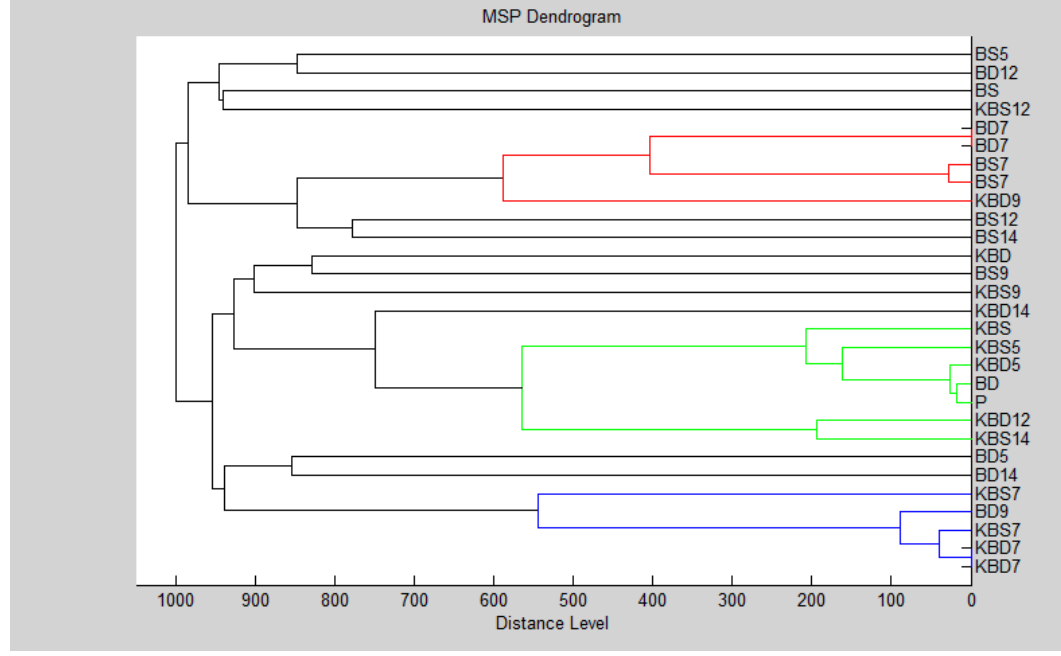
Figure 6. Dendrogram of B . subtilis generated using the MSPs for planktonic cells and control. Symbols in the abbreviations are as follows: B- B. subtilis ; K-control; S-glass; D-wood; P-planktonic cells.